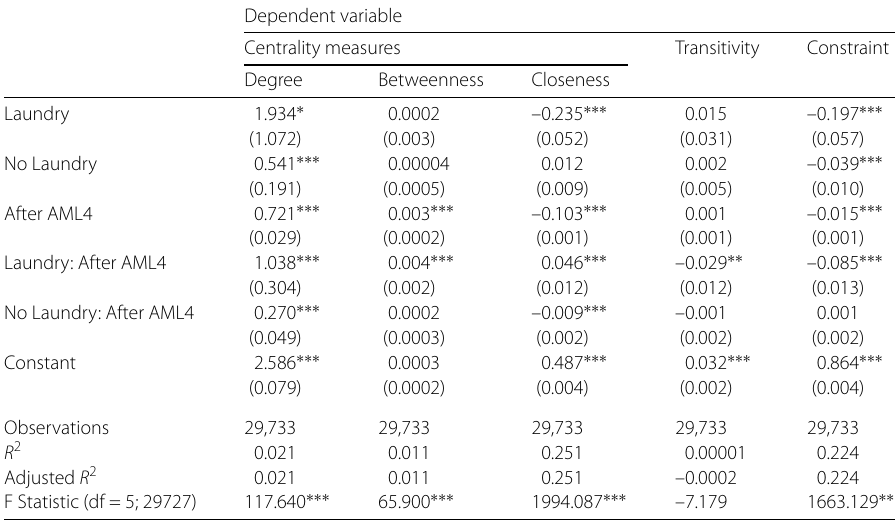
Table 7 Results of random effects regressions on individual centrality and position for people and companies